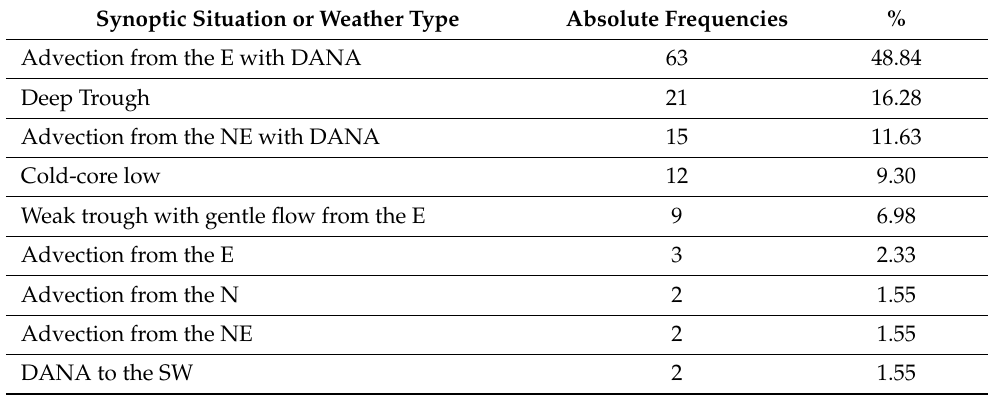
Table 2. Atmospheric situations causing intense rainfall episodes analysed in the study according to Mart í n Vide